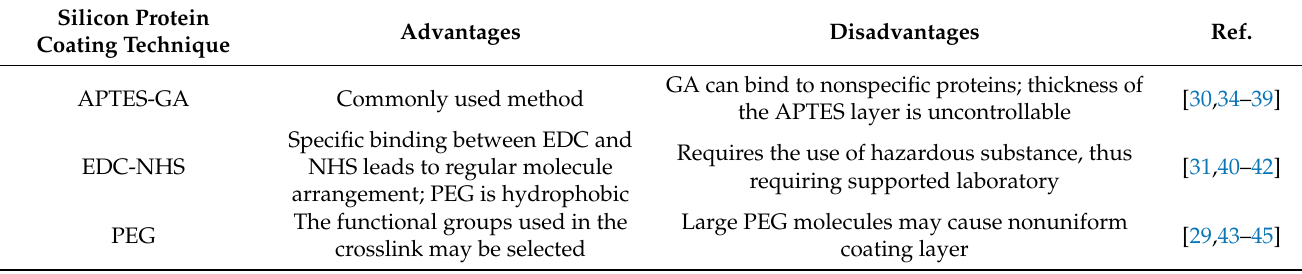
Table 1. Comparison of silicon protein coating